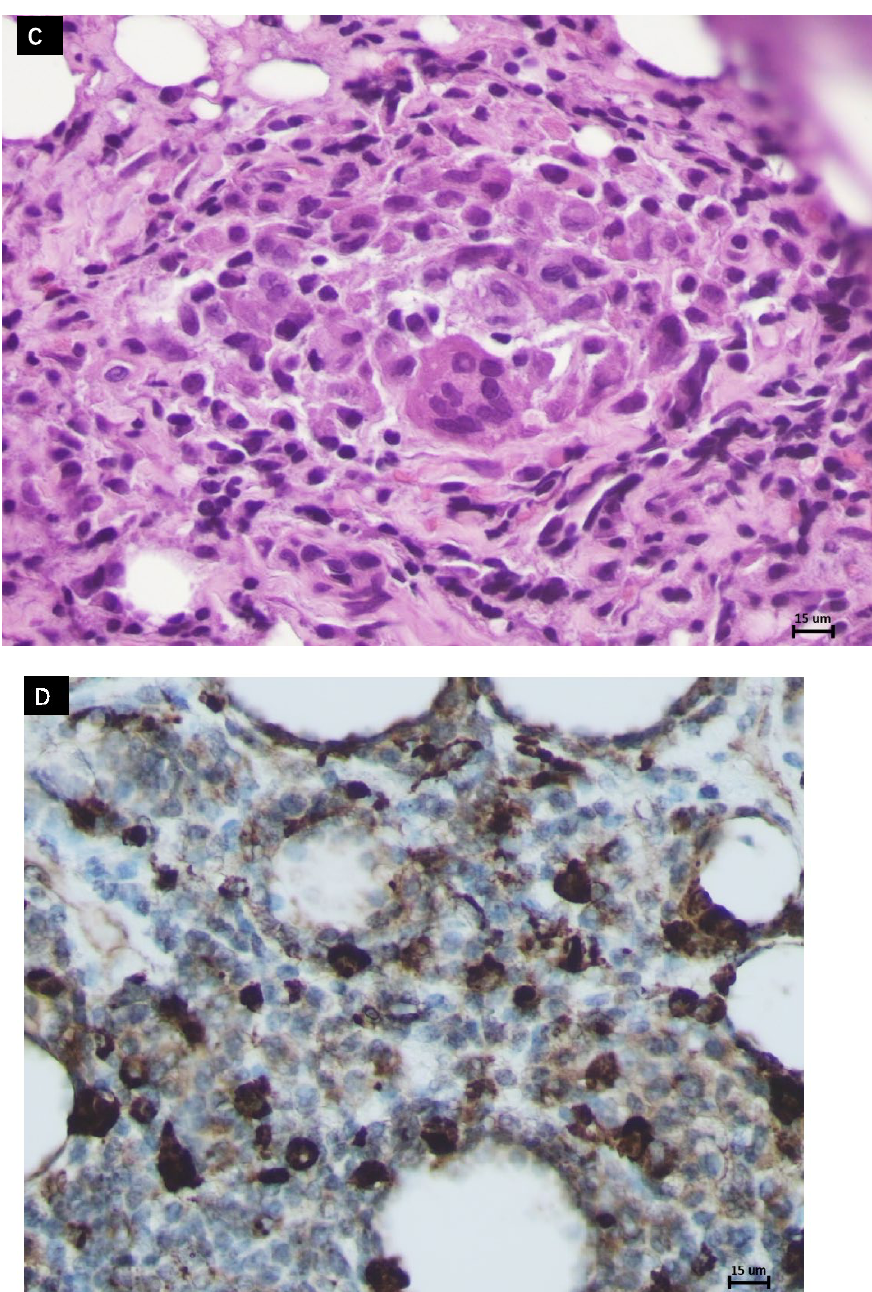
Figure 2. The histopathological study revealed a lymphoplasmacytic and fibroblastic infiltration with marked fibrosis. ( A ) The multinucleated giant cells (arrows) indicated prominent granulomatous inflammation (H and E stain, origin X100). ( B ) Lymphoplasmacytic infiltration with significant fibrinoid necrosis in the wall of vessels (asterisk) suggested vasculitis (H and E stain, origin X100). ( C ) Higher power field to highlight the inflammatory infiltrate. ( D ) The multinucleated giant cells are CD68-positive inflammatory foreign body type multinucleated giant cells.